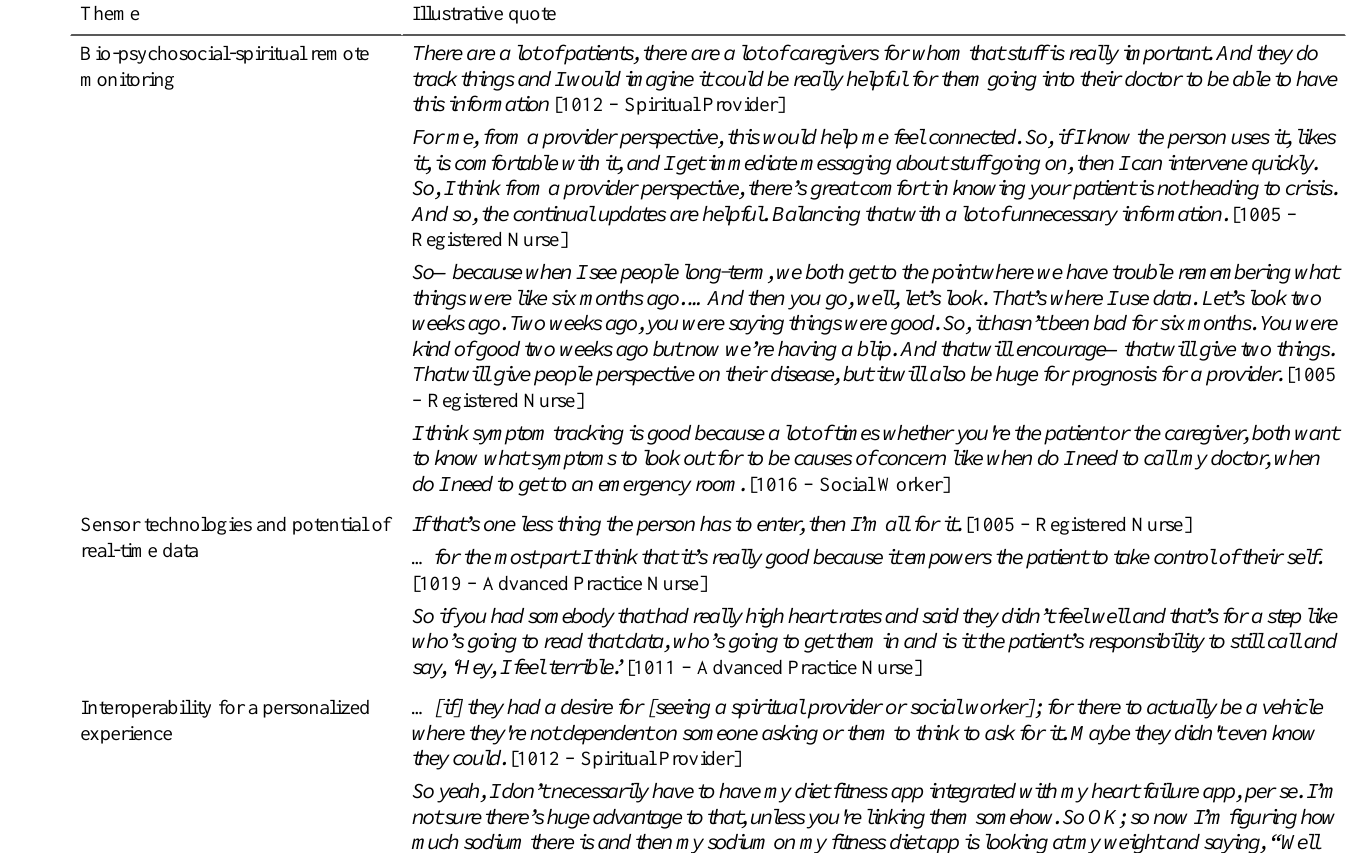
Table 1. Summary of themes with supporting quotes from participant